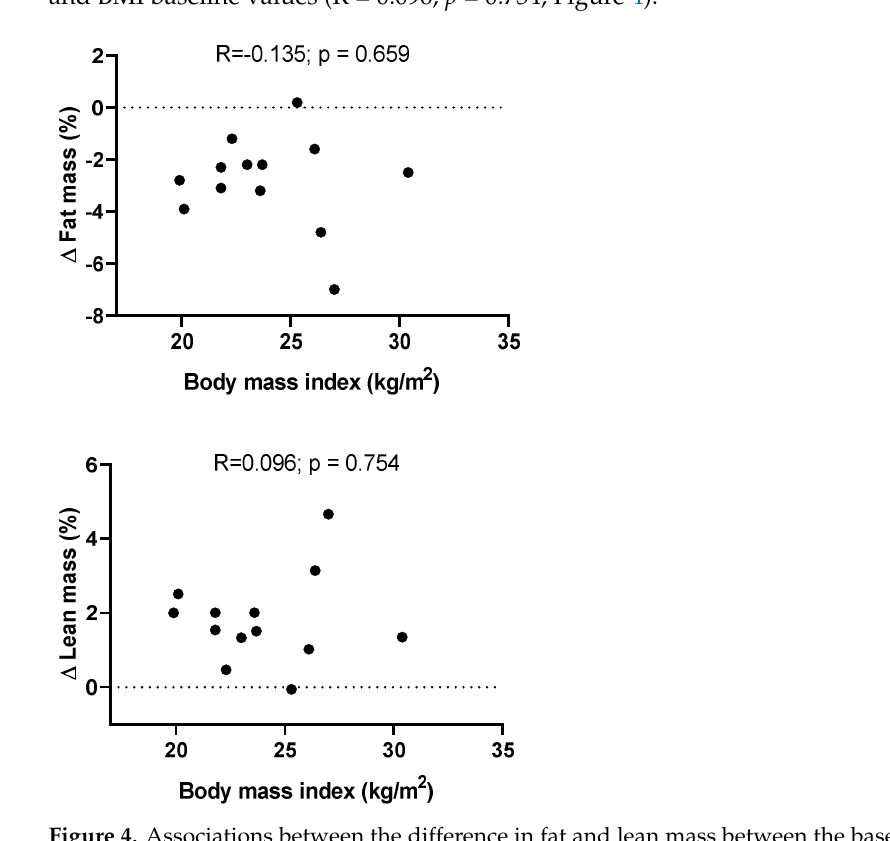
Figure 4. Associations between the difference in fat and lean mass between the baseline and post- intervention, and the body mass index at baseline.